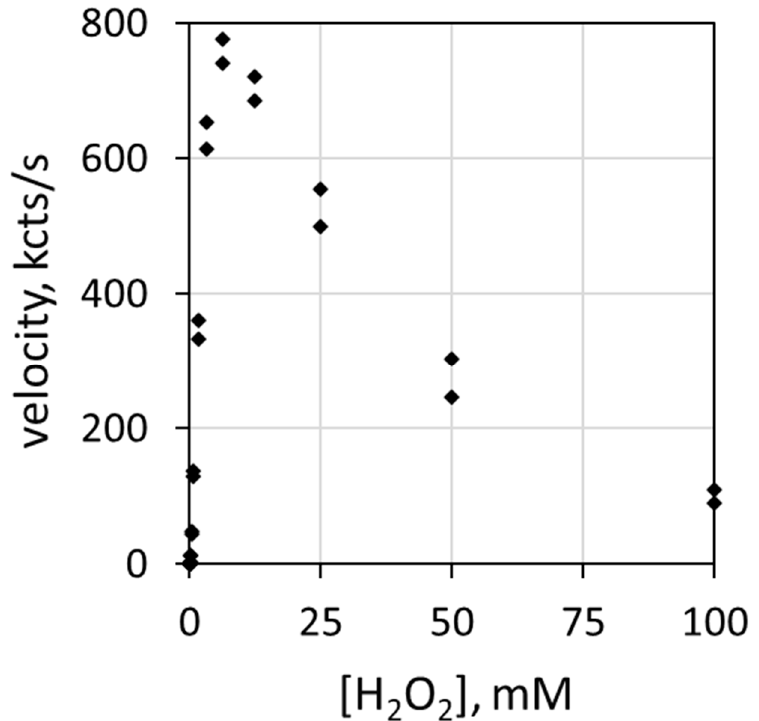
Figure 1. Plot of luminescence velocity against H 2 O 2 concentration using 78 nM MPO with 100 mEq/L Cl − and 51 µ M luminol in 50 mM acetate buffer at pH 5.0. Reaction was initiated by contact mixing of all components. The final volume was 0.9 mL.